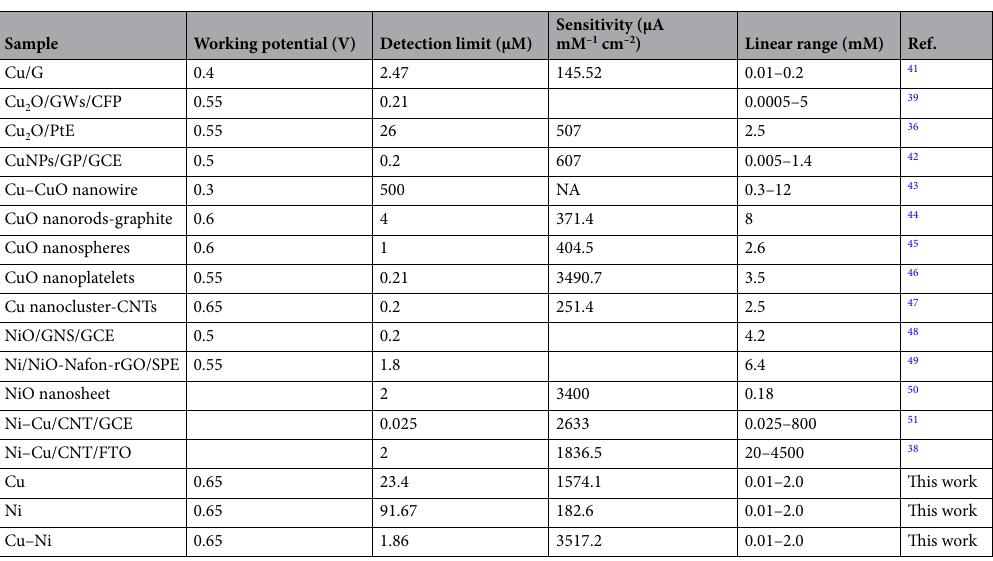
Table 1. Comparison of the glucose sensing characteristic of Cu–Ni thin film electrode with other Cu and Ni based